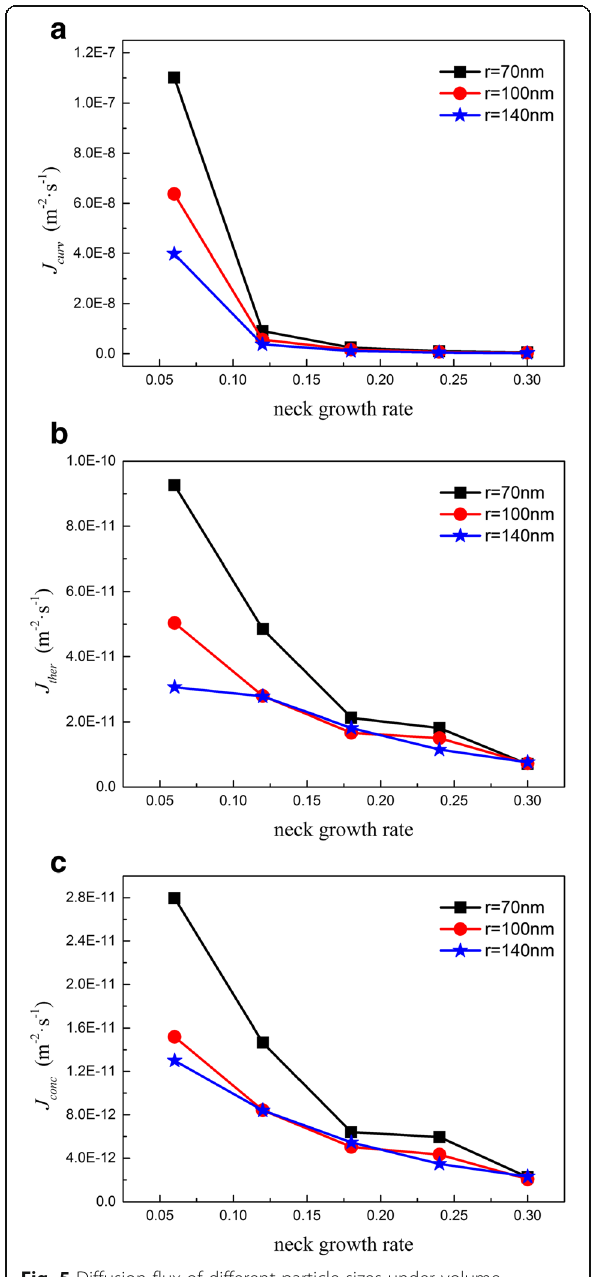
Fig. 5 Diffusion flux of different particle sizes under volume